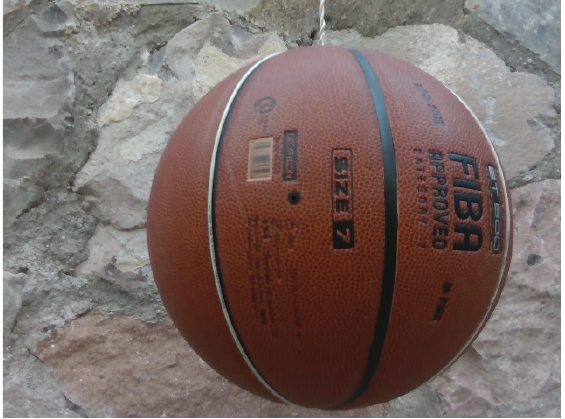
Figure 4. Scene experiment 1.